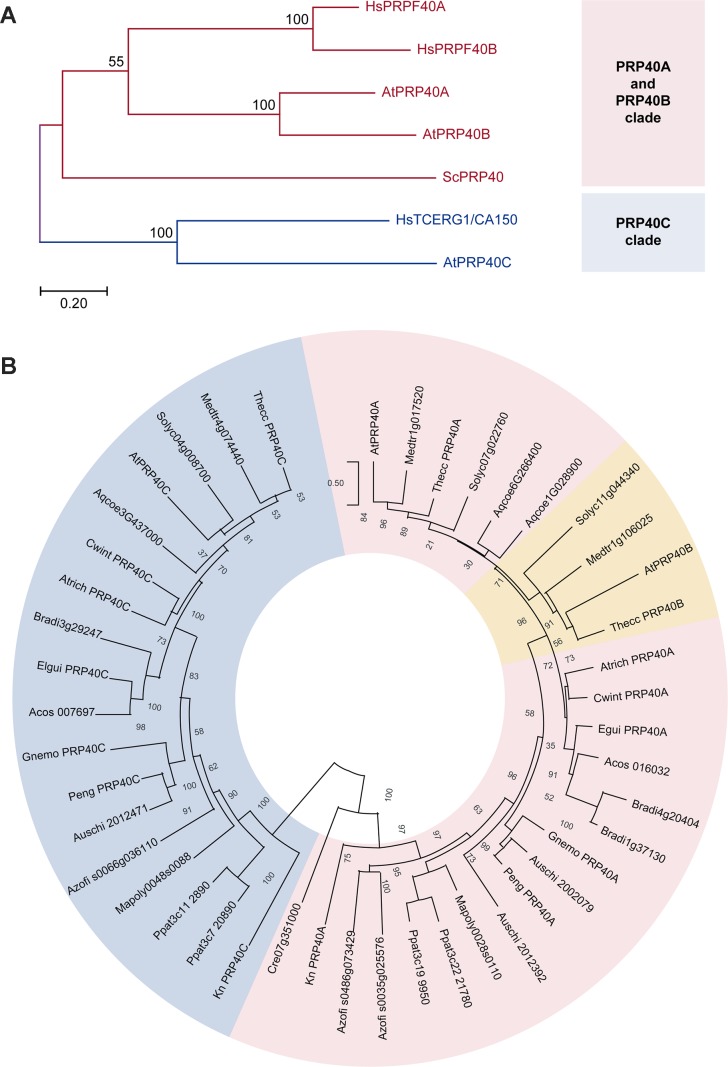
Phylogenetic analysis of the PRP40 family. Pink and blue shades indicate the PRP40A and PRP40C groups, respectively. Numbers indicate the percentage support for each node with 1,000 bootstrap iterations. (A) Comparison between the corresponding sequences of yeast (Sc, Saccharomyces cerevisiae), humans (Hs, Homo sapiens), and Arabidopsis (At, Arabidopsis thaliana). (B) Phylogenetic relationships of the PRP40 family in the Viridiplantae. The eudicot-specific duplication between A- and B-type sequences is indicated in orange; note that the two sequences from A. coerulea, a basal eudicot, do not clearly cluster with either group. Species identification: Medtr, Medicago truncatula; Thecc, Theobroma cacao, Solyc, Solanum lycopersicum; Aqcoe, Aquilegia coerulea; Atrich, Amborella trichopoda; Cwint, Canella winterana; Egui, Elaeis guineensis; Acos, Ananas cosmosus; Bradi, Brachipodium distachyon; Gnemo, Gnetum montanum; Auschi, Austrocedrus chilensis; Peng, Picea engelmannii, Azofi, Azolla filiculoides, Ppat, Physcomitrella patens; Mapoly, Marchantia polymorpha; Kn, Klebsormidium nitens; Cr, Chlamydomonas reinhardtii.